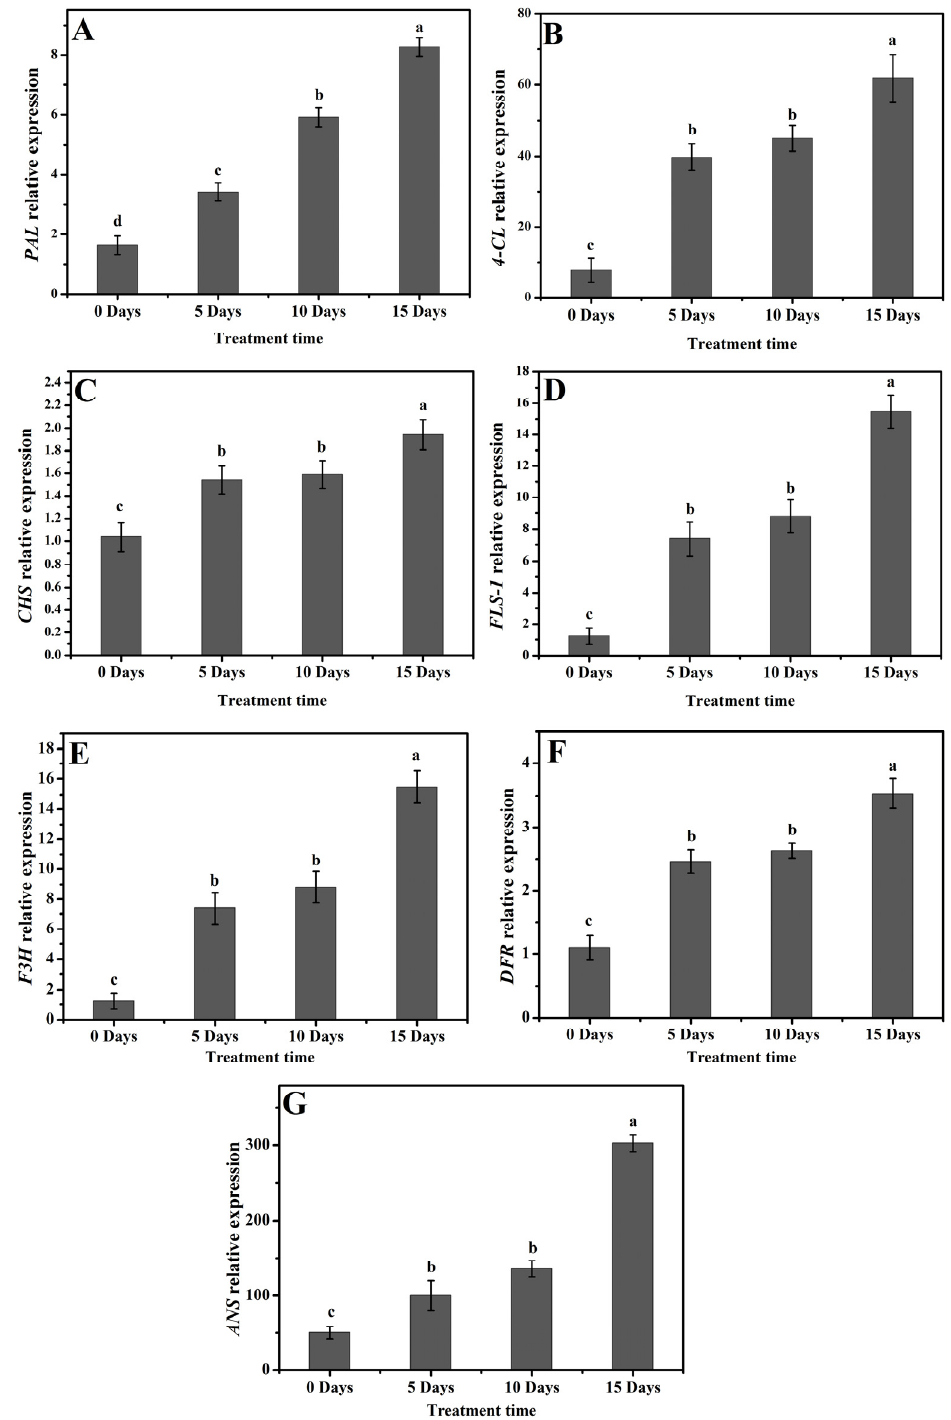
Figure 4. Relative expression of genes involved in the flavonoid biosynthesis pathway under drought stress in poplar 717 leaves. ( A ) PAL , phenylalanine ammonia-lyase, ( B ) 4-CL , 4-coumarate CoA ligase, ( C ) CHS , chalcone synthase, ( D ) FLS-1 , flavonol synthase, ( E ) F3H , flavanone 3-hydroxylase, ( F ) DFR , dihydroflavonol-4-reductase, ( G ) ANS , anthocyanidin synthase. The gene expression values are presented as means ± standard error (SE) ( n = 3). The different small letters indicate a significant difference ( p < 0.05) among different